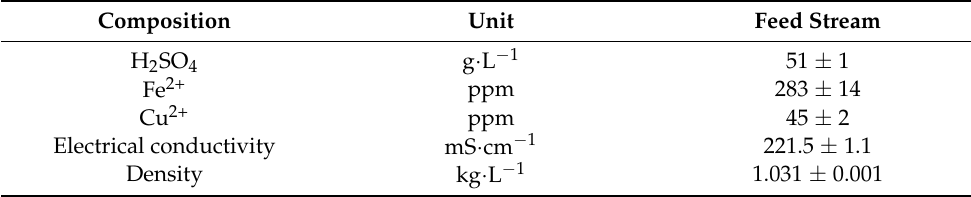
Table 11. Average composition of feed